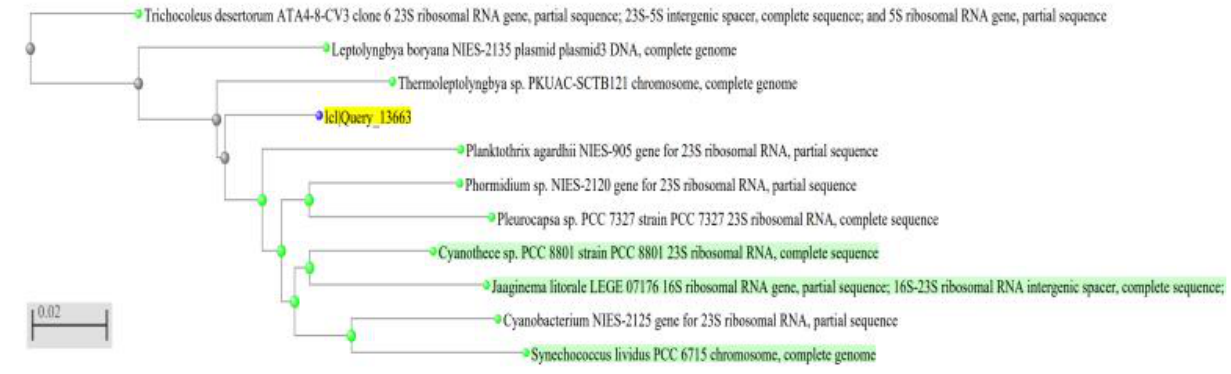
Figure 2. A neighbor-joining phylogenetic tree of Thermoleptolyngbya sp. The sequence of the organism under study is highlighted in yellow. Green highlights reference database sequences.